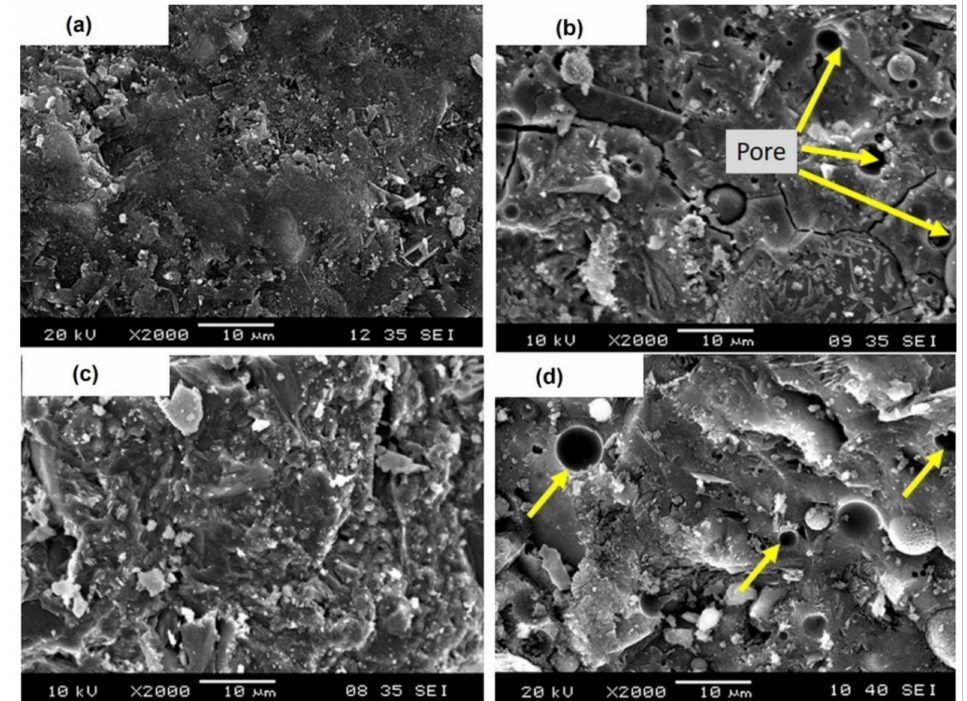
Figure 10. The morphologies of fly ash and metakaolin blended geopolymers composites with ( a ) 1.0 wt% monoaluminium phosphate, ( b ) 3.0 wt.% monoaluminium phosphate, ( c ) 1.0 wt.% aluminum dihydrogen triphosphate and ( d ) 3.0 wt.% aluminum dihydrogen triphosphate. Reprinted with permission from Ref. [83]. Copyright 2021, with permission from Elsevier. Table 2. Chemical composition and physical properties of cementitious materials used in geopolymers concrete composites. ChemicalComposition(wt.%) PhysicalProperties CoalType FlyAsh